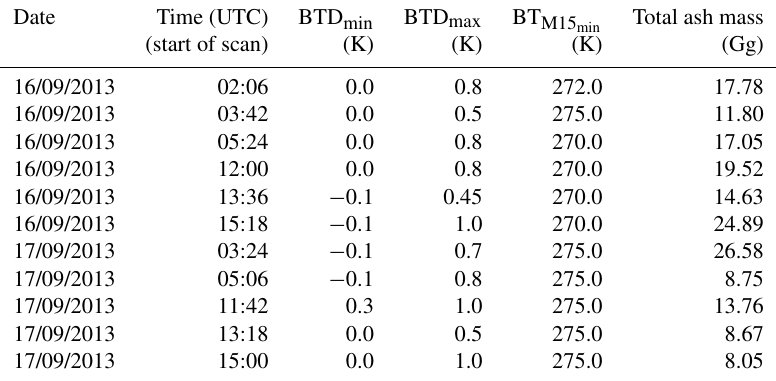
Table 2. VIIRS data used in this study. The study area is limited to the area delimited by 54–65 ◦ N, 12–26 ◦ W. VIIRS data were ordered from